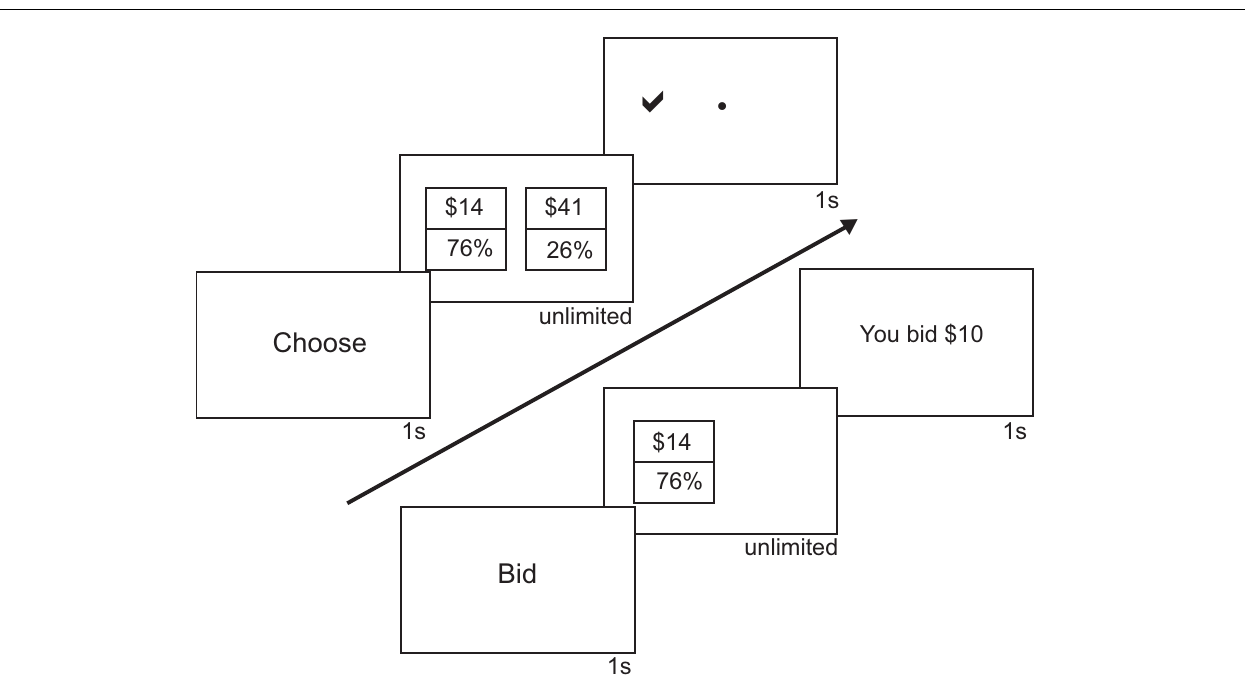
gamble. For bid trials, subjects saw “Bid” for 1s. Subjects then saw one gamble, either a $-bet or a P-bet gamble, on the left side of the screen.To the right of the gamble was a “$” where subjects bids would appear. Subjects had unlimited time to submit their bids. After submitting their response, subjects would see the amount they